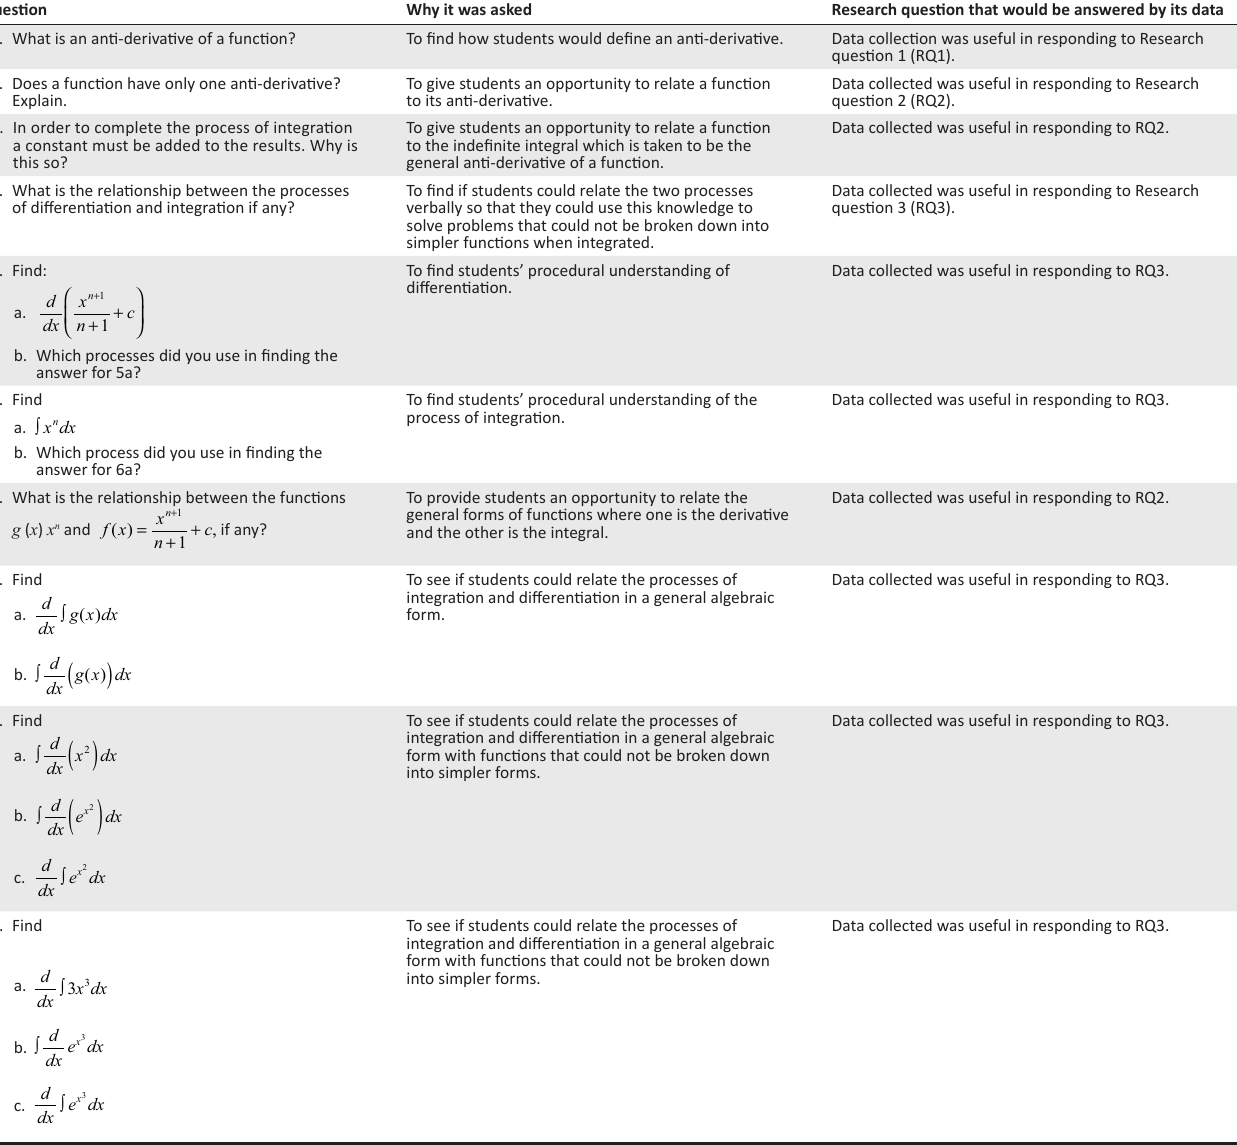
TABLE 1: The questions, their justification and research questions their data would answer.